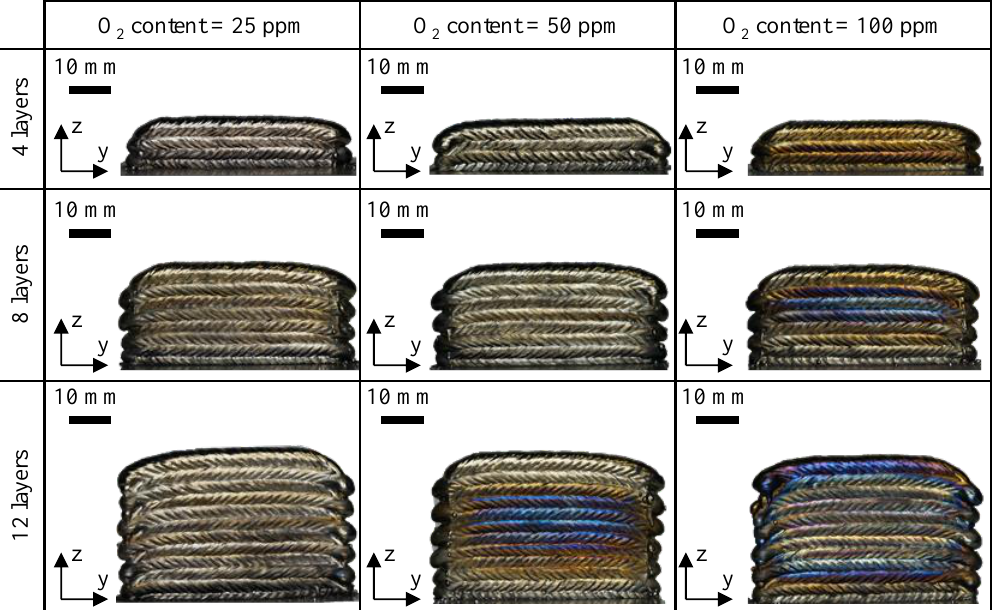
Figure 8. Matrix showing pictures of manufactured walls with different sizes ( rows ) and with different oxygen contents in the build chamber ( columns ).